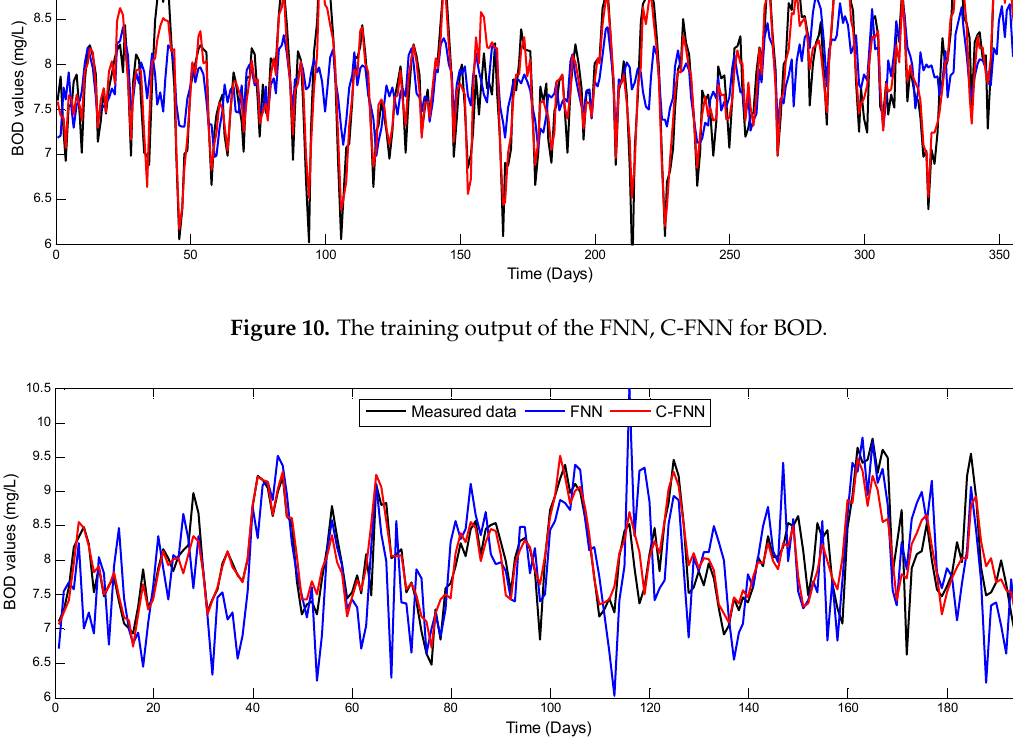
Figure 12. The training error of the FNN, C ‐ FNN for BOD.